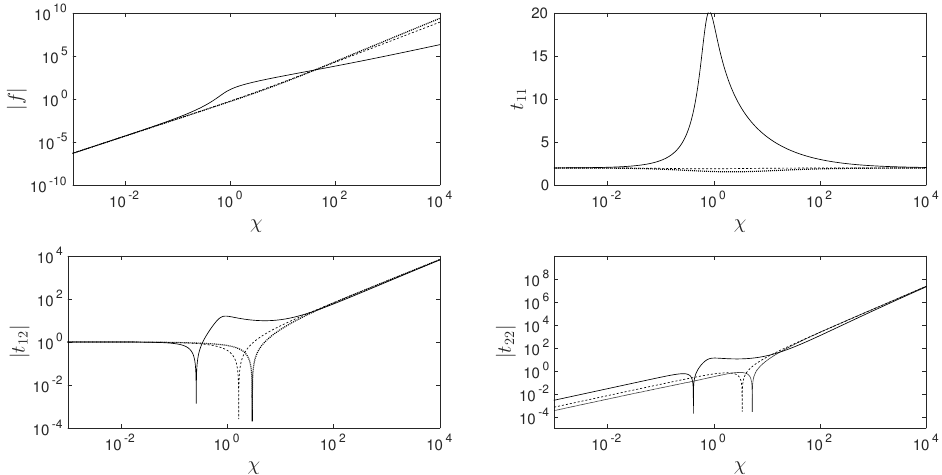
1 and p 0 = 1 for q = n . The results are −